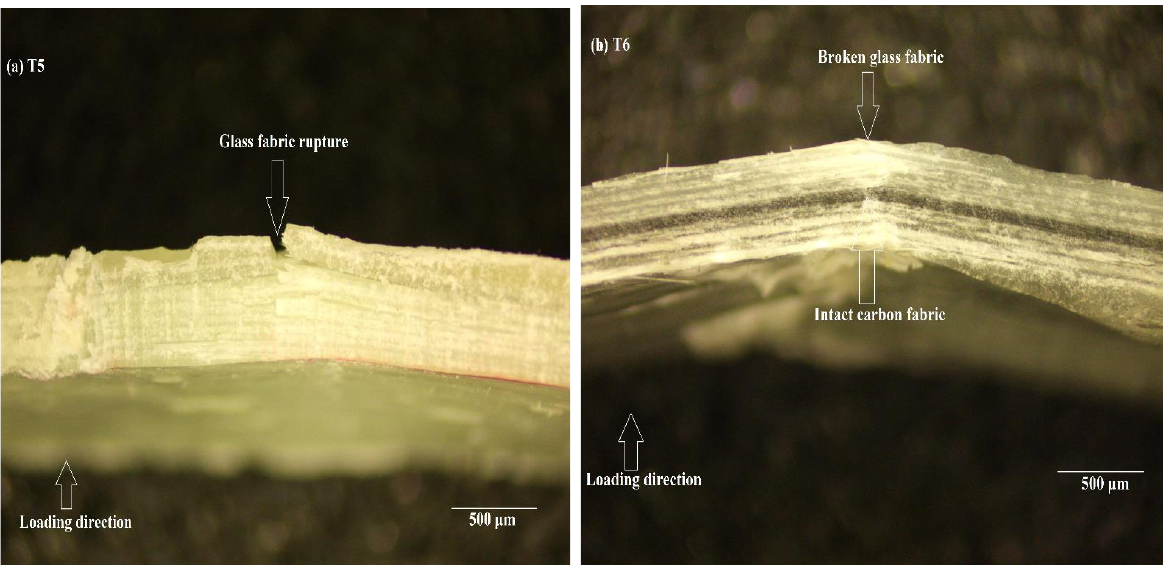
Figure 7. Magnified image of damaged cross-section of T5 and